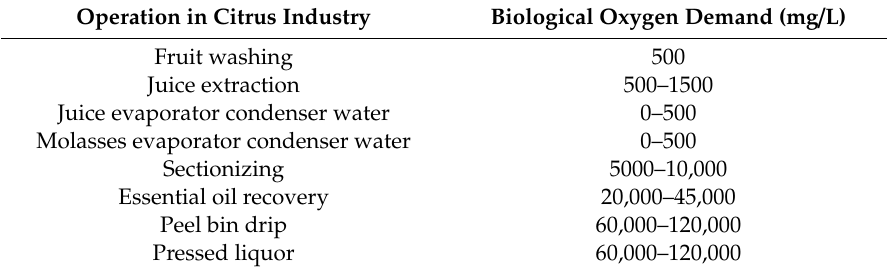
Table 2. The biological oxygen demand of citrus wastewaters generated during different processing operations [32] .